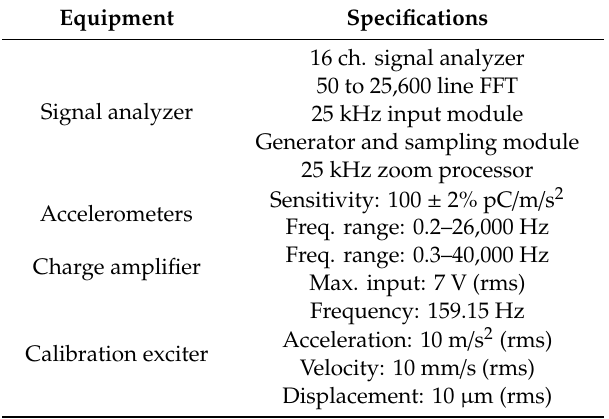
Table 3. Specifications of measurement and analysis equipment.